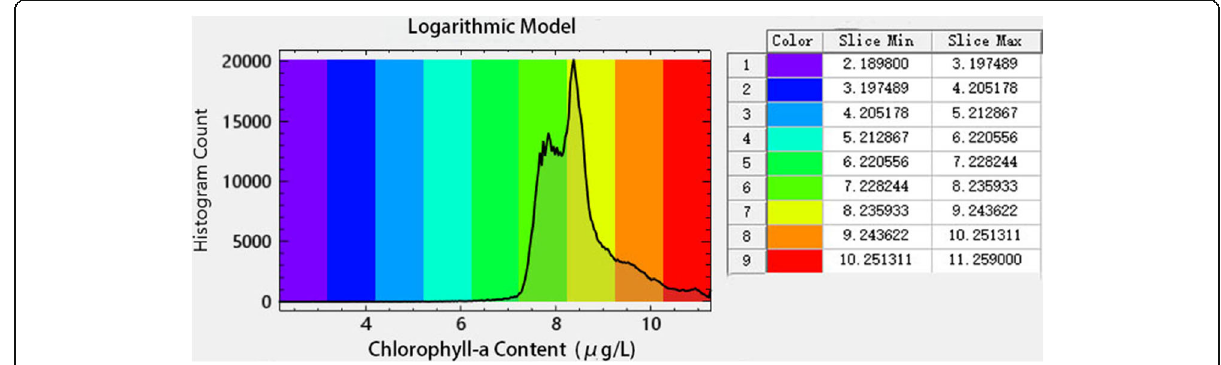
Fig. 13 The distribution of chlorophyll-a concentration in polynomial model